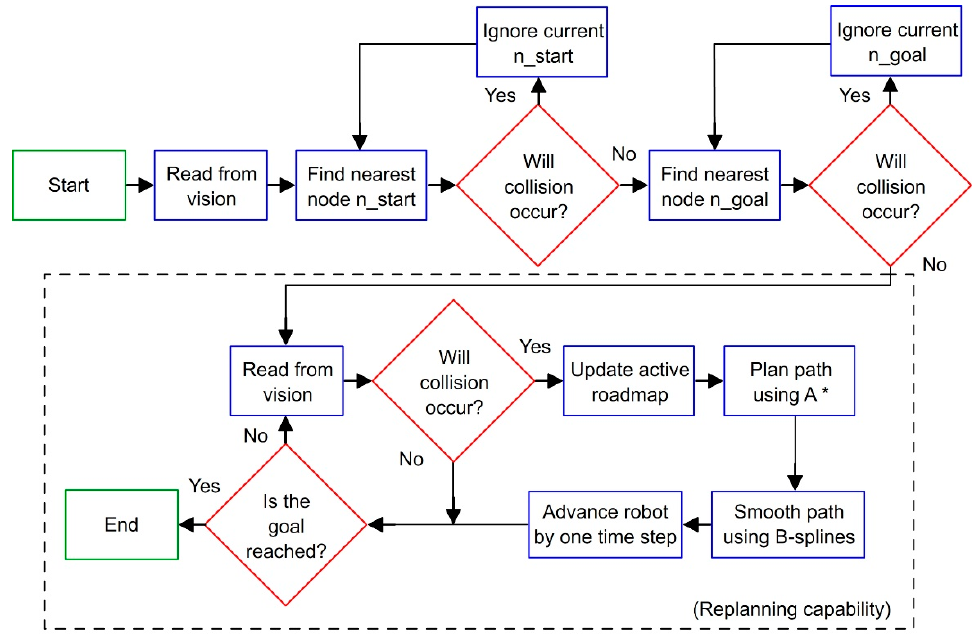
Figure 8. Flowchart for dynamic path planning [22]. The dashed box indicates re-planning capability.